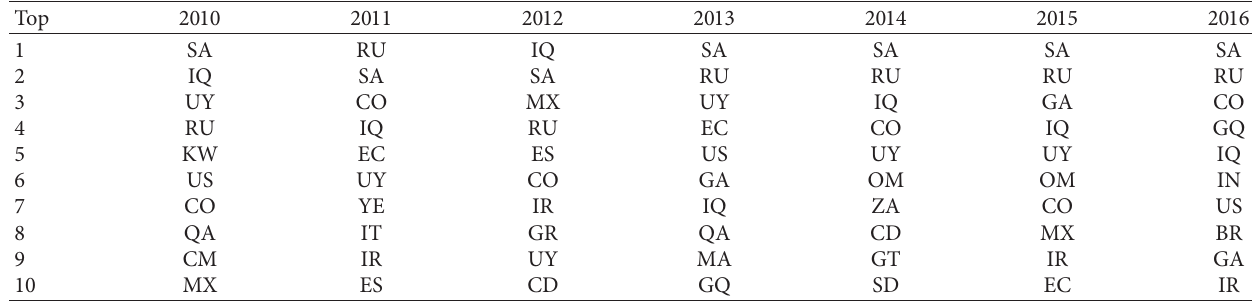
Table 4: The variance of the top 10 countries with node degrees in minimum spanning trees of crude oil trade after optimization during 2010 and 2016. The light gray spaces represent the major crude oil exporting countries (see Table 5 for the countries in the selected sample). Top